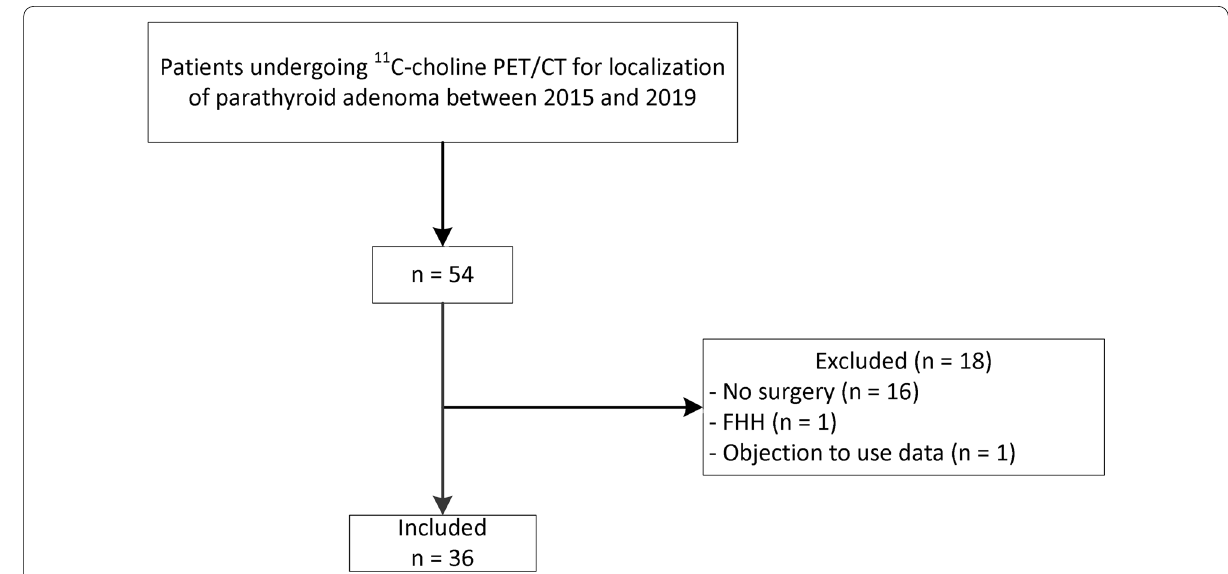
Fig. 1 Flowchart of patient inclusion. FHH